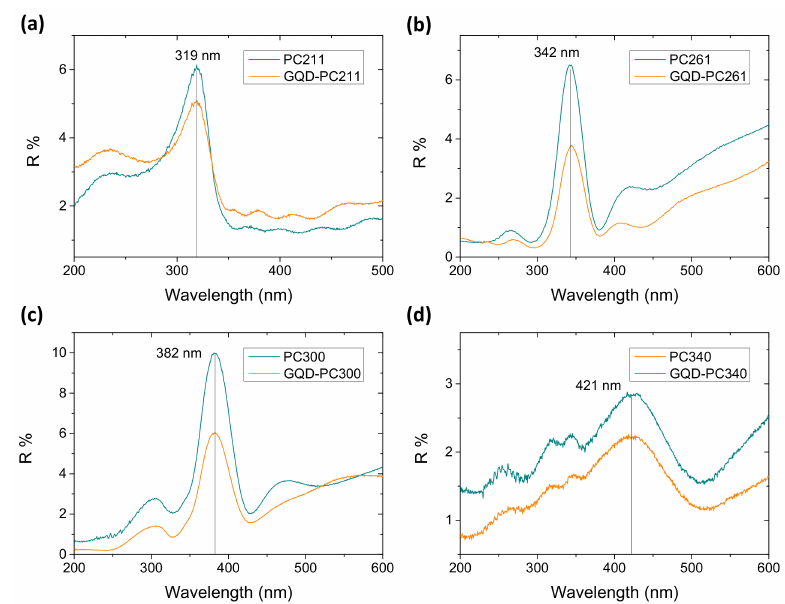
Figure 2. Specular reflectance (R%) spectra for the ( a ) PC211, ( b ) PC261, ( c ) PC300, and ( d ) PC340 photonic films before and after QGDs surface modification at 15 ◦ incidence